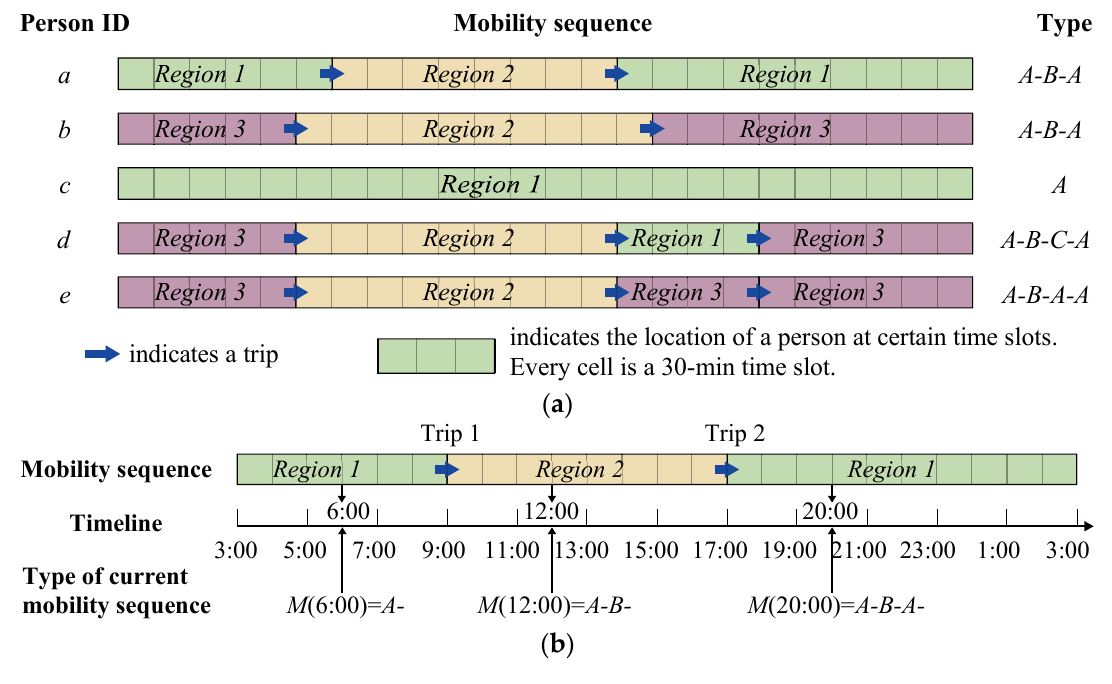
Figure 6. Mobility sequences and their types: ( a ) Types of mobility sequences M ; ( b ) An example of types of current mobility sequences M ( t )